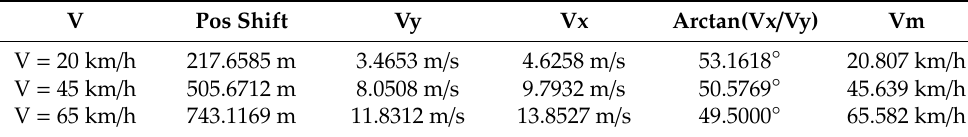
Figure 6. Processing result of moving target. Table 4. Velocity estimation results. Table 4. Velocity estimation results. Table 5. GF-3 radar parameters.